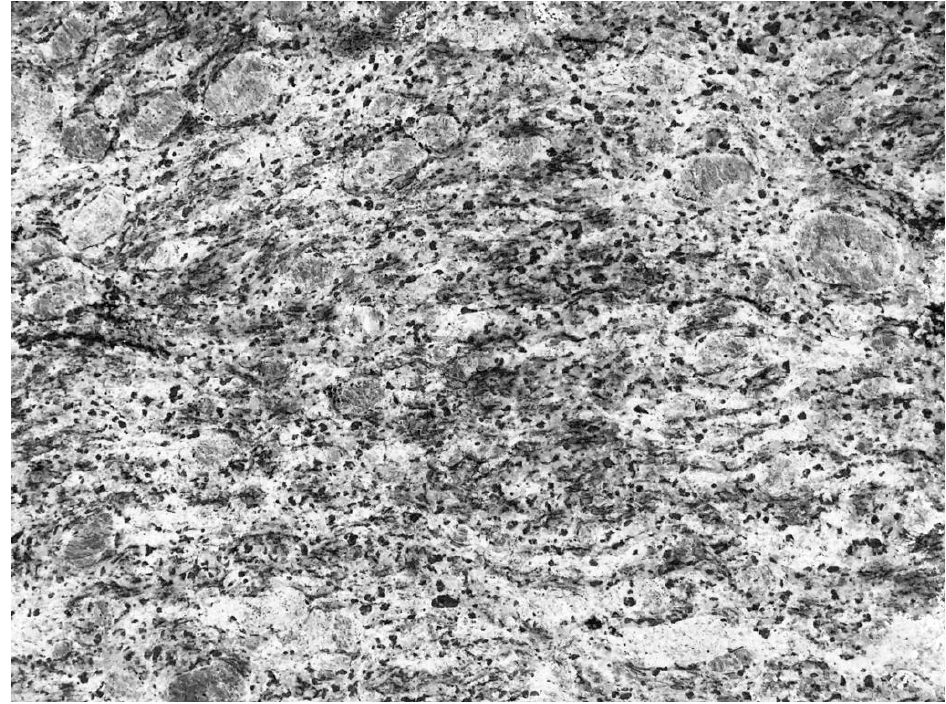
Figure 1. Illustration of a perceived pathological entity of what appears to be a granular cell tumour.